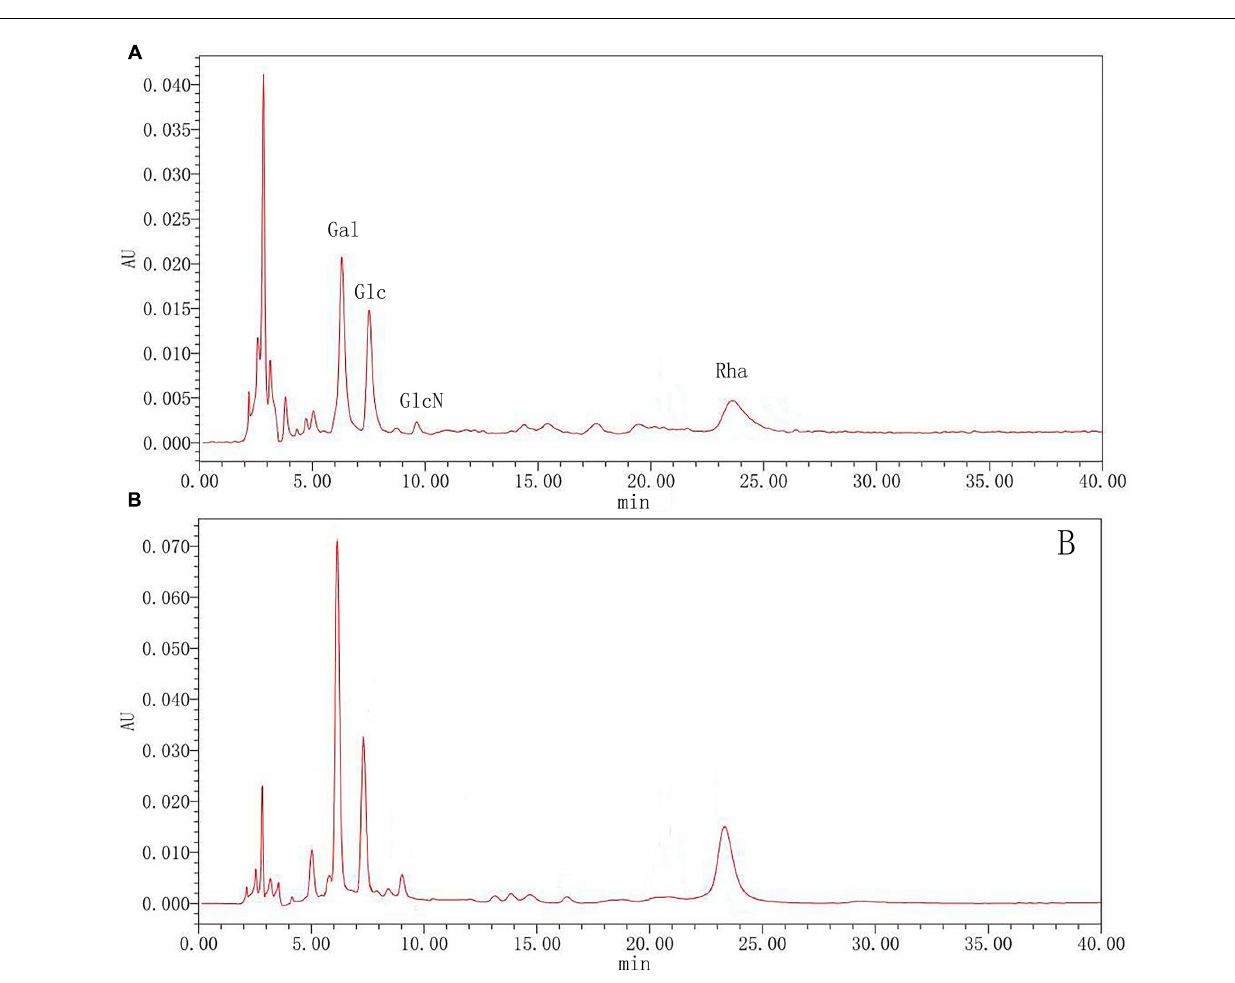
FIGURE 7 | High performance liquid chromatography (HPLC) chromatograms of monosaccharides after hydrolysis of polysaccharide in control (A) and rutin (B) groups.